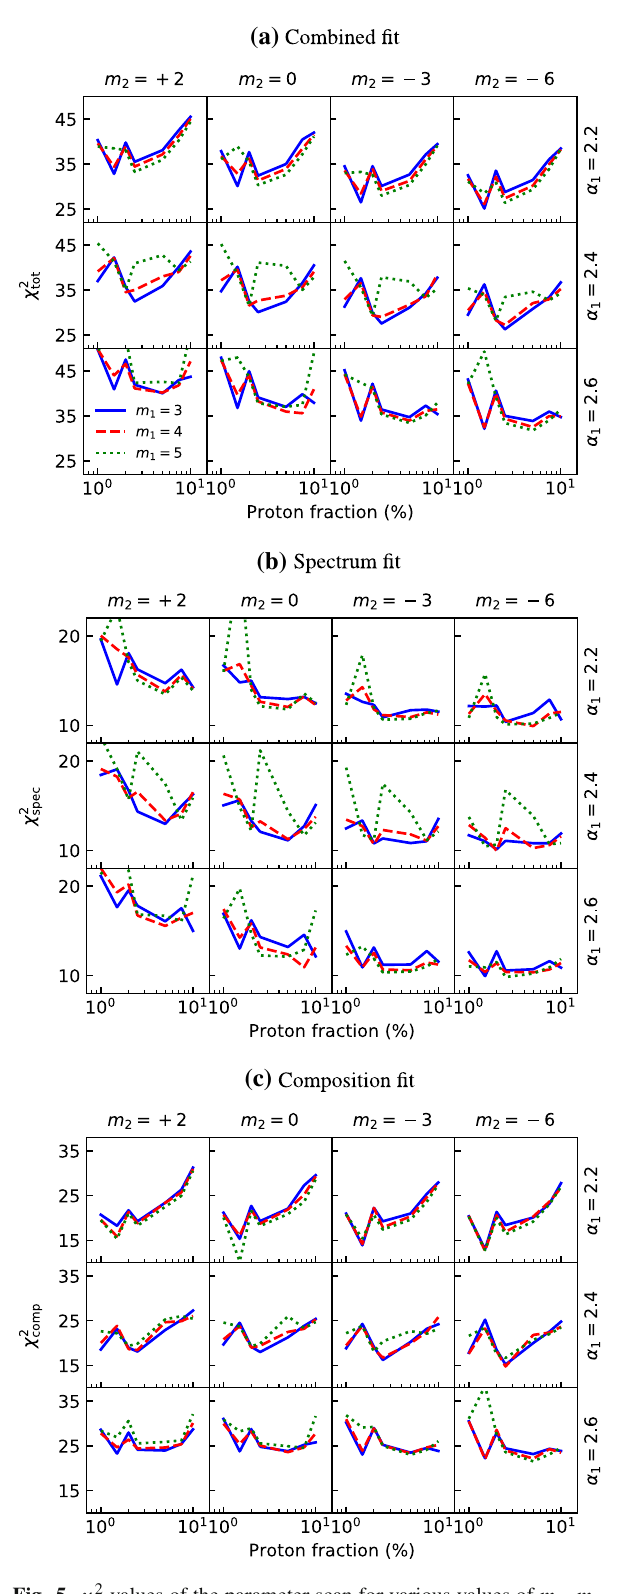
Fig. 5 χ 2 values of the parameter scan for various values of m 1 , m 2 , α 1 , as a function of the proton fraction f H . The top, middle, and bottom panels indicate the values for combined fit, spectrum fit, and composi- tion fit, respectively